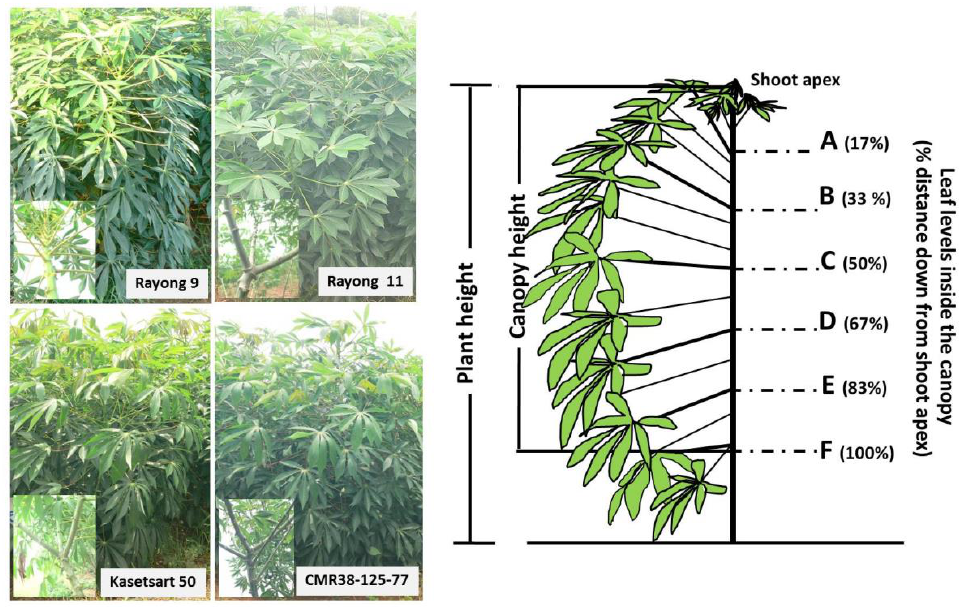
Figure 1. Four cassava genotypes including Rayong 9, Rayong 11, Kasetsart 50, and